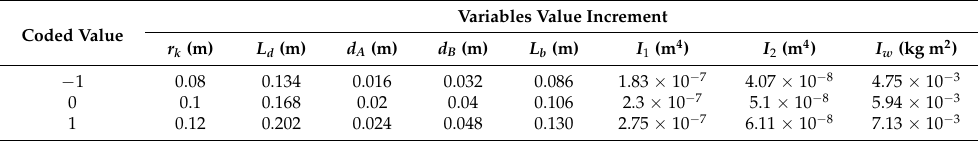
Table 6. Design variables and design level in DOE.